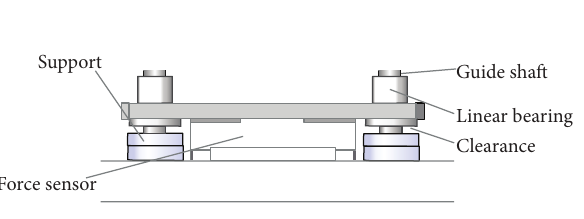
Figure 7: The press-mounting apparatus.